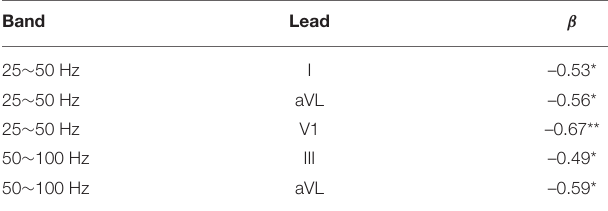
TABLE 3 | Leave-one-out (LOO) classification results (%).